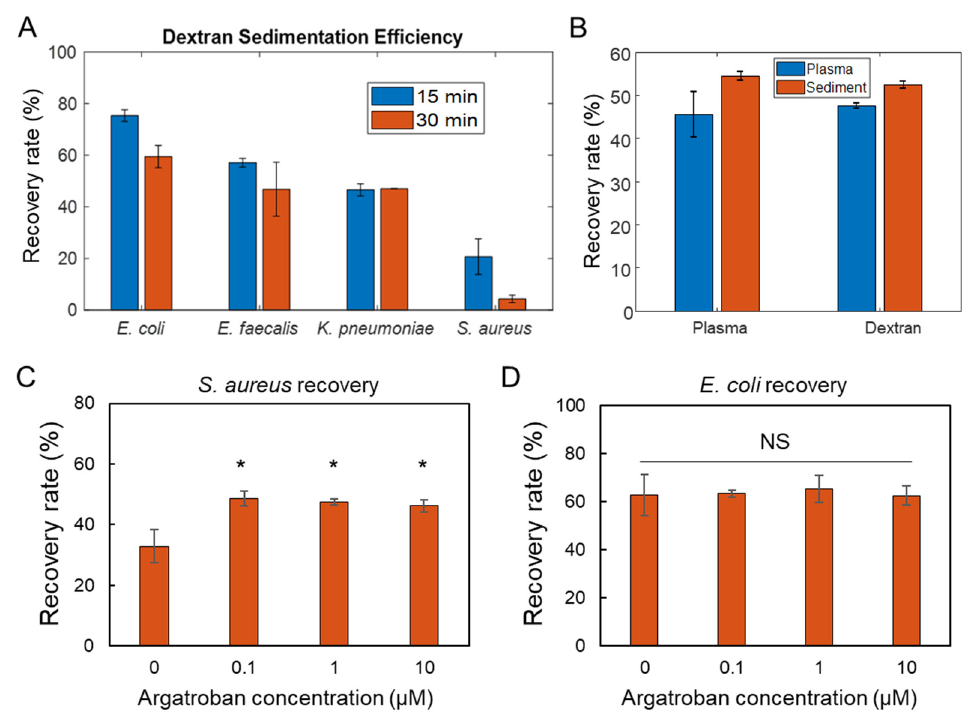
Figure 3. Dextran sedimentation efficiency for common pathogens. ( A ) Recovery rates of E. coli , E. faecalis , K. pneumoniae , and S. aureus after dextran sedimentation. ( B ) Control experiments with plasma and dextran solution for characterizing the recovery rate of S. aureus . ( C , D ) Recovery rates of S. aureus and E. coli with a thrombin inhibitor, argatroban. The results were obtained after 30 min dextran incubation. Data represent mean ± s.e.m. ( n = 3). One-Way ANOVA with Tukey’s HSD test. * p < 0.05, NS = not significant.